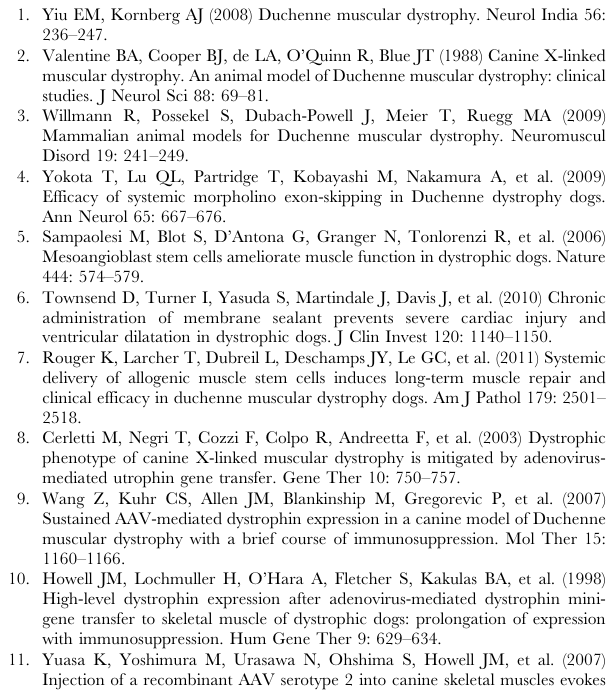
Table S1 Main results of the multi-parametric evalua- tion of treated versus healthy and untreated GRMD dogs. The mean (SD) of each evaluated parameter is provided in this table, at 4 time points of the study: from treatment initiation (2 months) to treatment end (9 months), with two intermediary points (4 and 6 months). The results are given for the treated dogs (GRMD CsA + P ) and for the untreated GRMD dogs (GRMD ctrl ), as well as for the healthy population when this last information is available. Figure S1 Clinical motor scoring grid. The clinical motor scoring grid encompasses 11 items, allowing the operator to evaluate the dog by observing postural abnormalities, contrac- tures, ambulation, or by performing simple tests as the hopping test or the ability to stand up or cross an obstacle. Each item can be scored from 0 (normal situation) to 2 (the worst situation), giving a score on 22 points, the score 0/22 being the one a healthy dog should obtain, and 22/22 describing the worst motor clinical situation a GRMD could be in. Abbreviations: IDS: inter-digital space; from lat. rec.: from lateral recumbency. Figure S2 Illustration of the high prevalence of calcified myofibers in treated dogs. A: Macroscopically visible calcified myofibers in a GRMD CsA + P tibialis cranialis muscle. B: Alizarin red S (ARS) staining of a GRMD CsA + P tibialis cranialis muscle